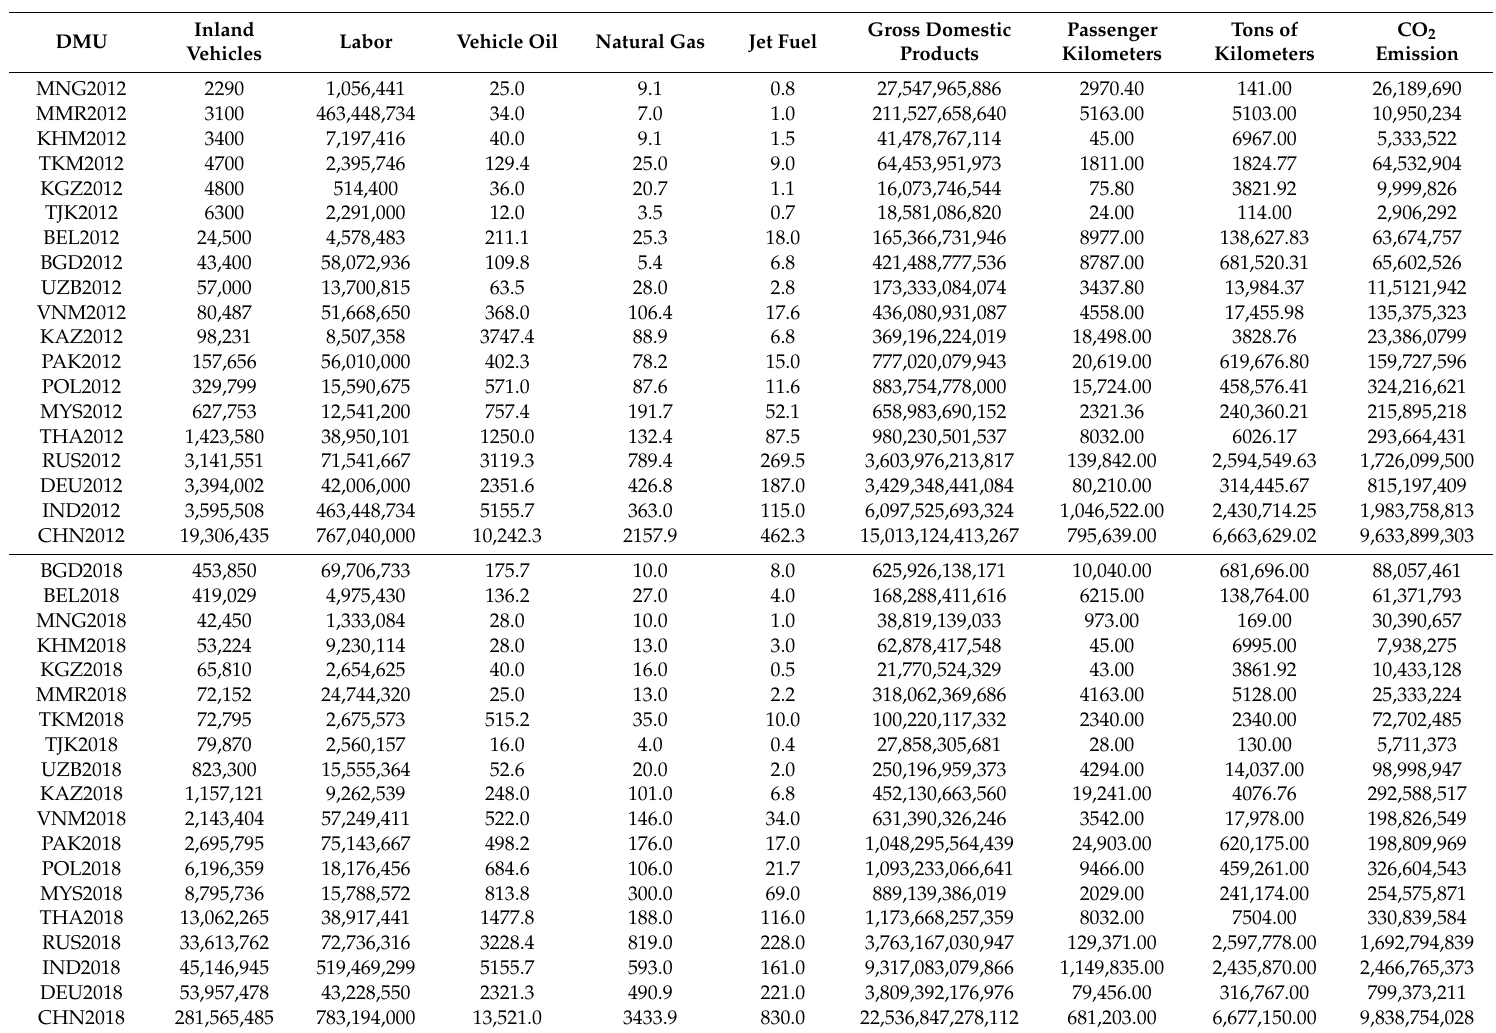
Table 4. Raw data for countries of BRI corridors in the year 2012 and